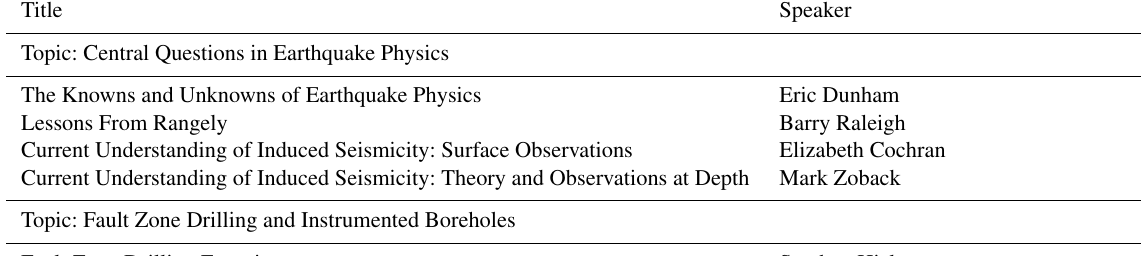
Table 1. SEISMS keynote